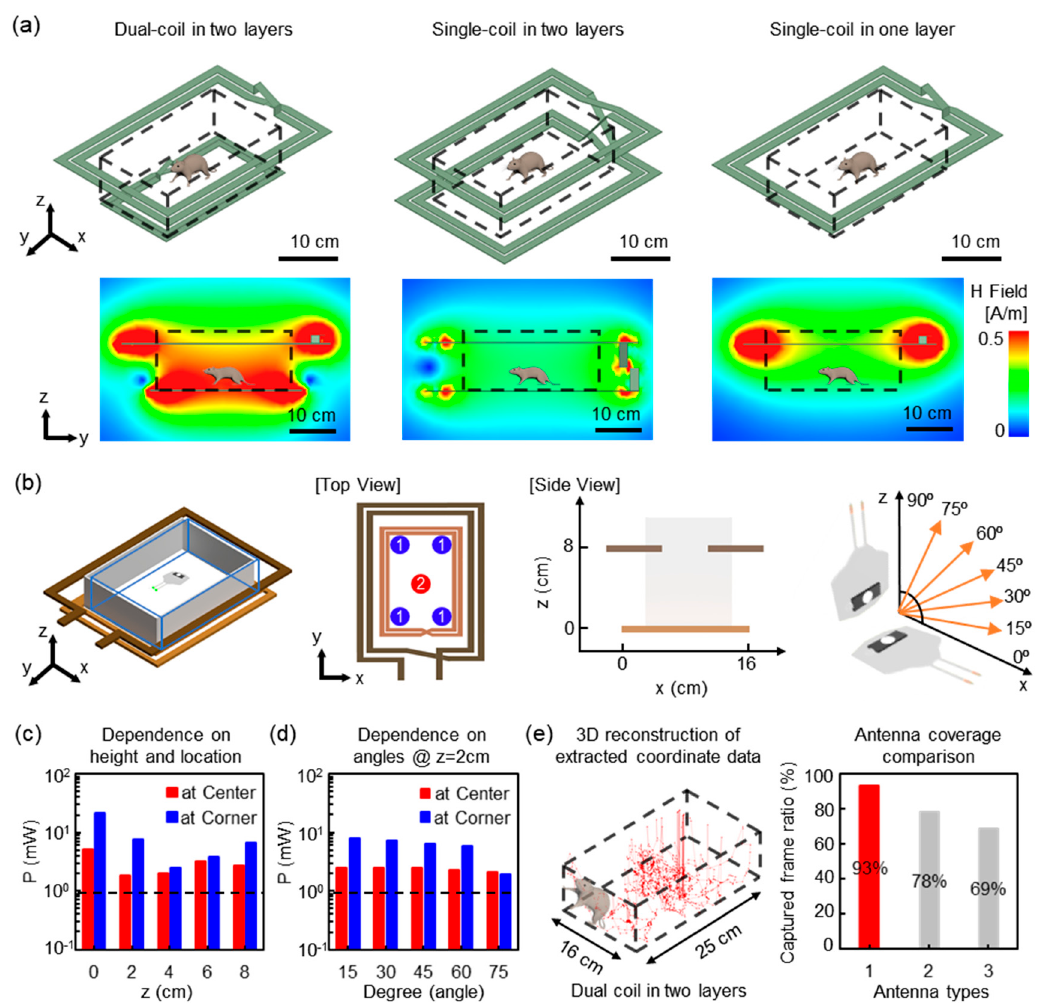
Figure 4. Modeling and experimental results for the power transmission from antennas and angular coverage. ( a ) Electromagnetic simulations of the wireless power transmission efficiency for three different TX systems. ( b ) Illustration of an experimental cage for evaluating an implantable device with a dual coil TX system. ( c ) Plots of the measured electrical power as a function of the position along the Z-axis at a corner and at the center of the cage, respectively. ( d ) Plots of a residual dependence of the transmitted power on the relative orientation angle between the transmission antenna and the implantable device. Dotted lines indicate the threshold electrical power (0.9 mW) required for the activation of light-sensitive opsins; 0.9 mW electrical power corresponds to an optical power of 15.7 mW/mm 2 . ( e ) 3D representative plot of post-processed reconstructed data from extracted coordinate information from two recorded videos (Left), and comparison of wireless coverage (Right) of dual-coil in two layers (denoted, 1) with that of single-coil in two layers (denoted, 2) and single-coil in one layer (denoted, 3).